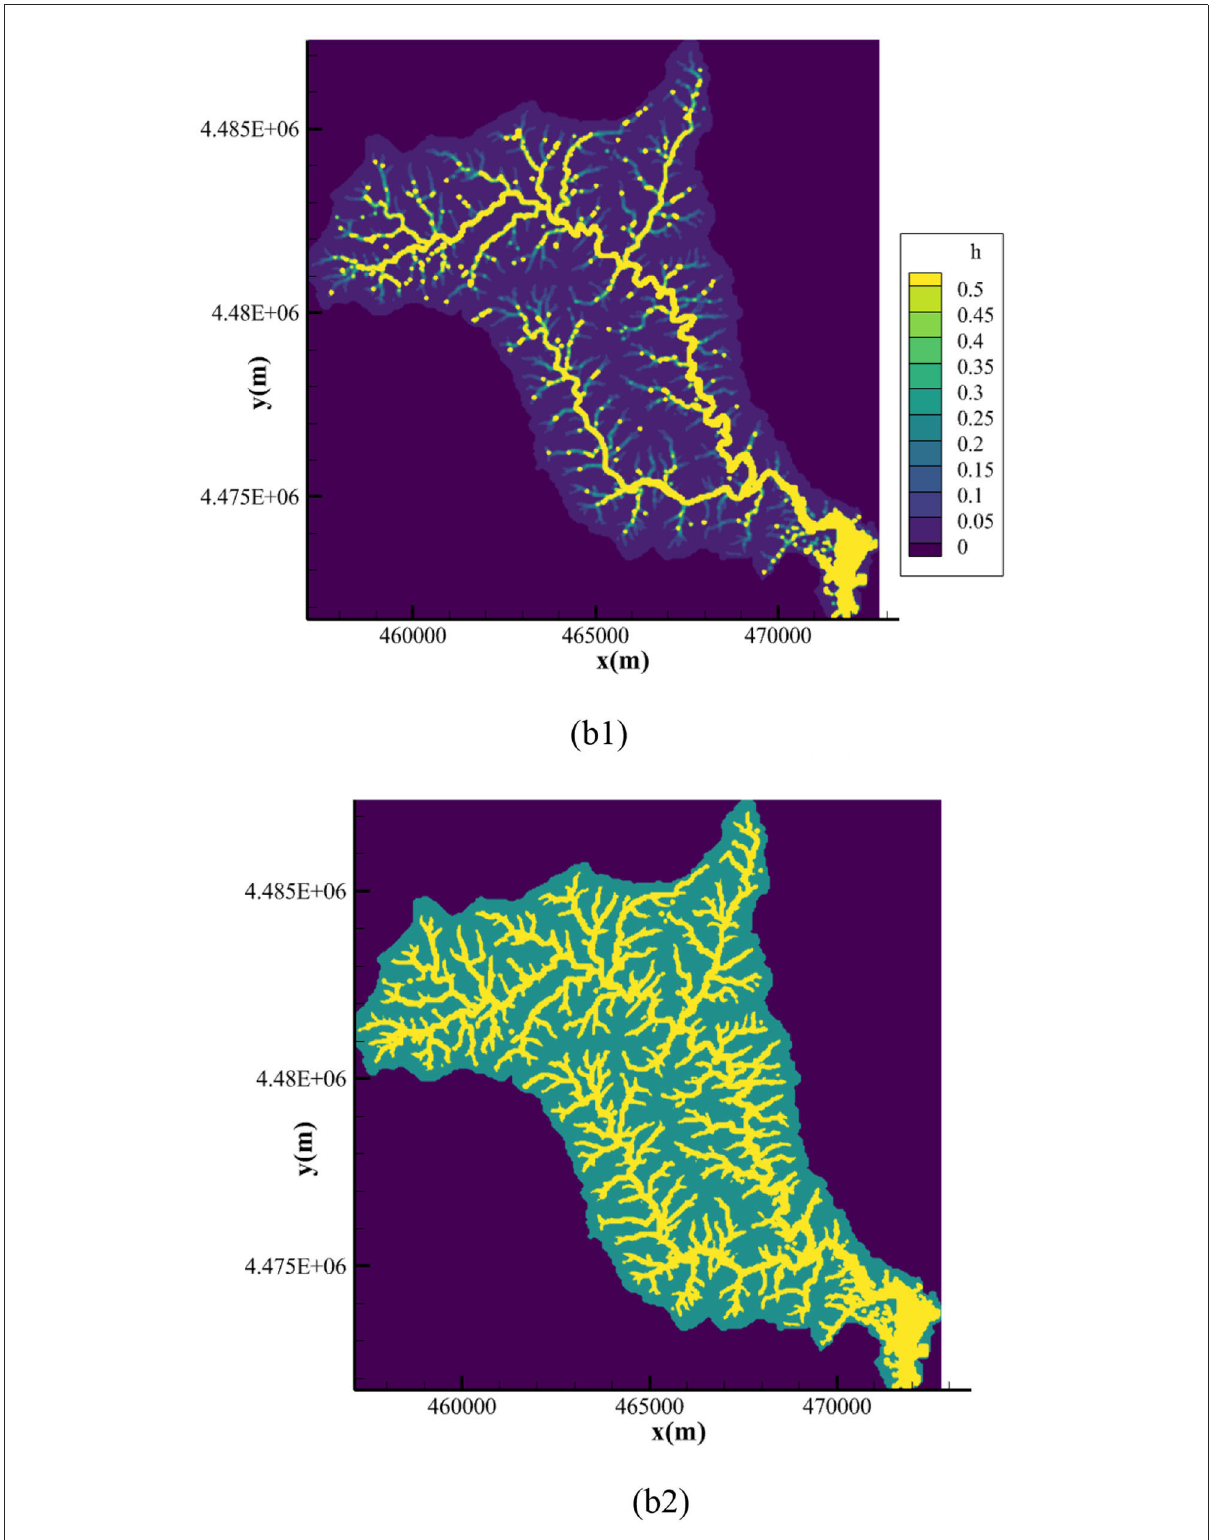
FIGURE13 Water depth and the location of coupling interface at different times. (a1) Water depth at t = 2,000s (m). (a2) Upland watershed and downstream waterbody at t = 2,000s. (b1) Water depth at t = 70,000s (m). (b2) Upland watershed and downstream waterbody at t = 70,000